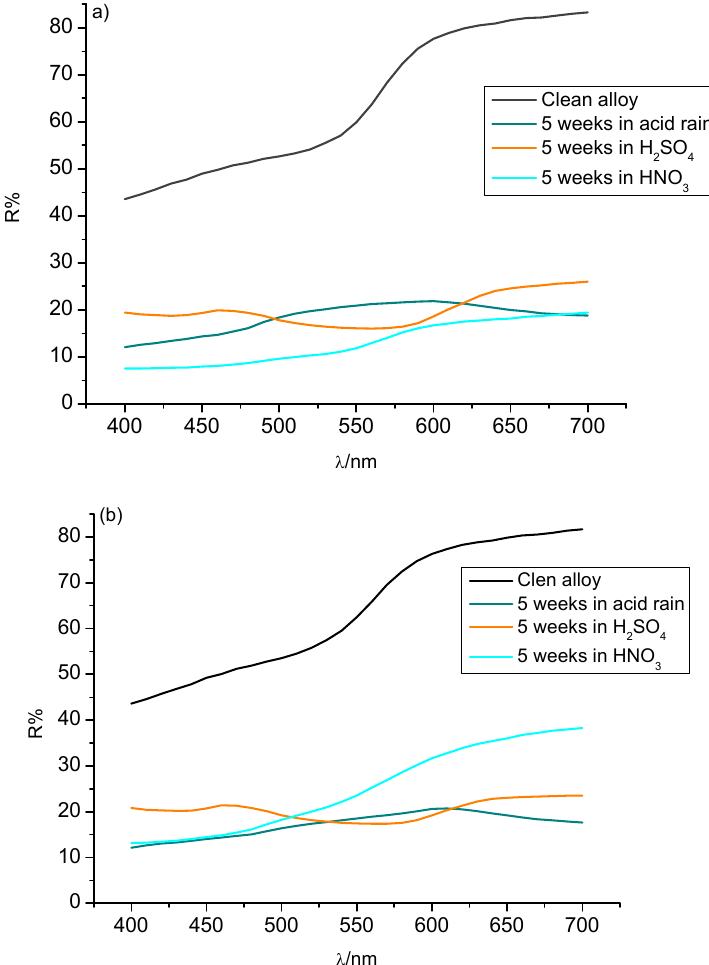
Figure 2. Reflectance curves of ( a ) 3% Sn bronze and ( b ) 7% Sn bronze after five weeks of immersion in artificial acid rain, 0.1 M sulphuric, and 0.1 M nitric